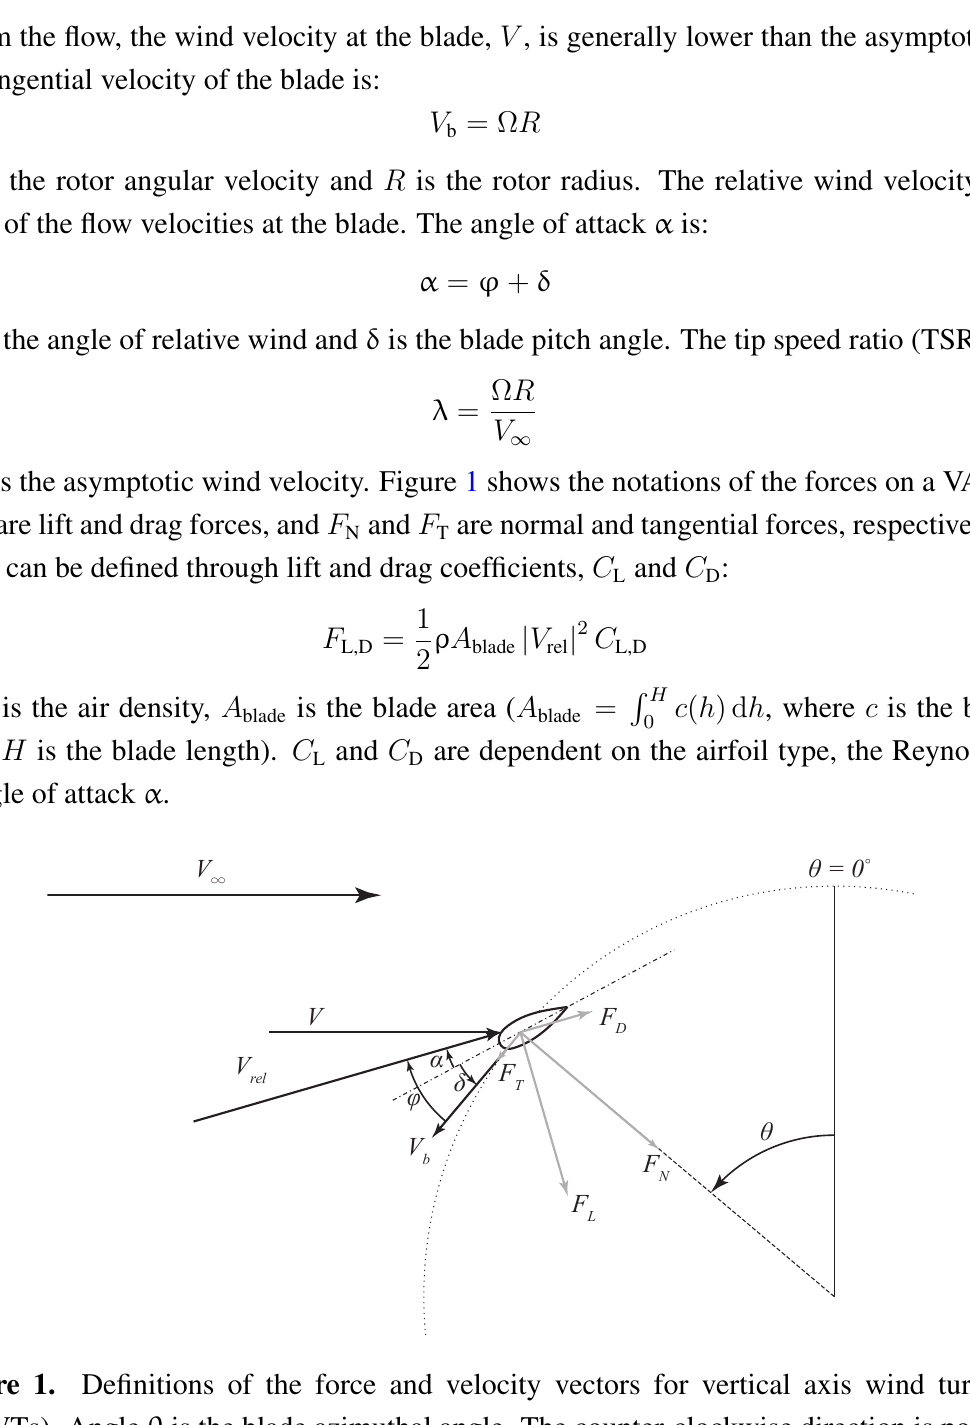
and V b rel in the N